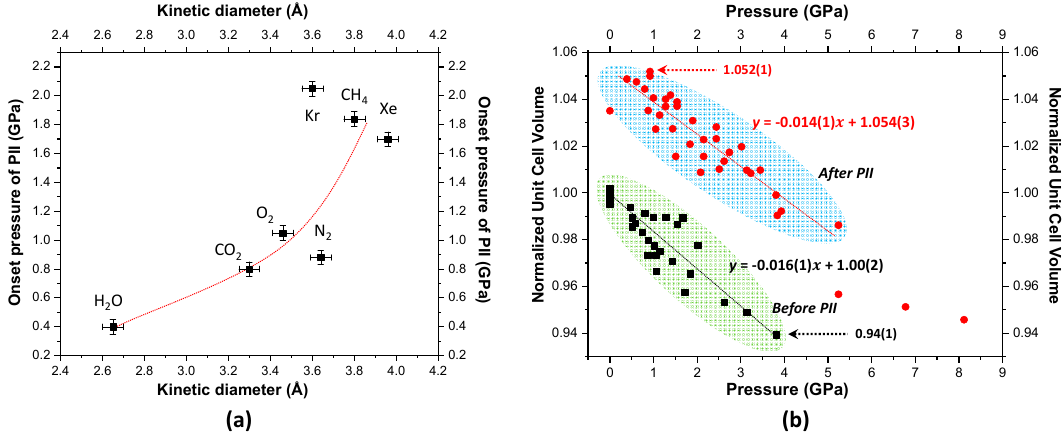
Figure 4. ( a ) Onset pressure of pressure-induced insertion vs. kinetic diameter of molecule as PTM; ( b ) normalized volume plot in a presence of different PTMs (N 2 , O 2 , CH 4 , CO 2 , H 2 O, Xe and Kr) [9,13] .